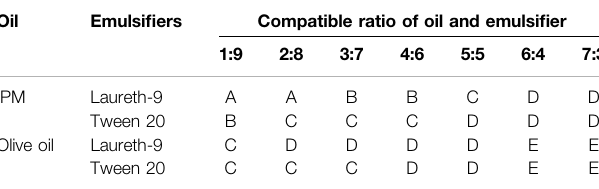
TABLE 4 | Compatibility test between emulsi fi ers and oils. Oil Emulsi fi ers